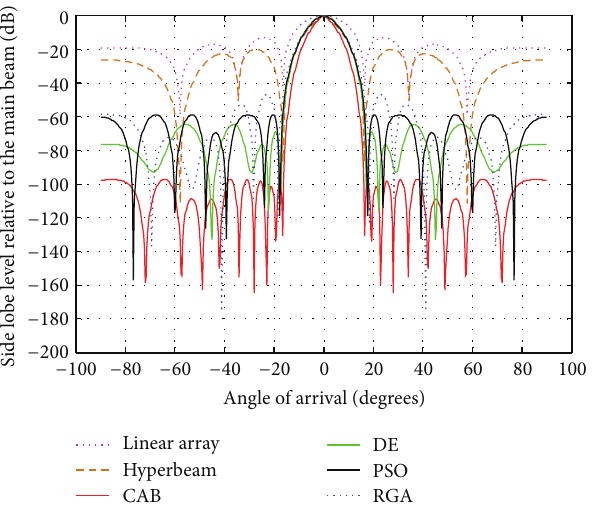
Figure 9: Best array pattern found by CAB for the 20-element array at 𝑢 = 1 with improved SLL.